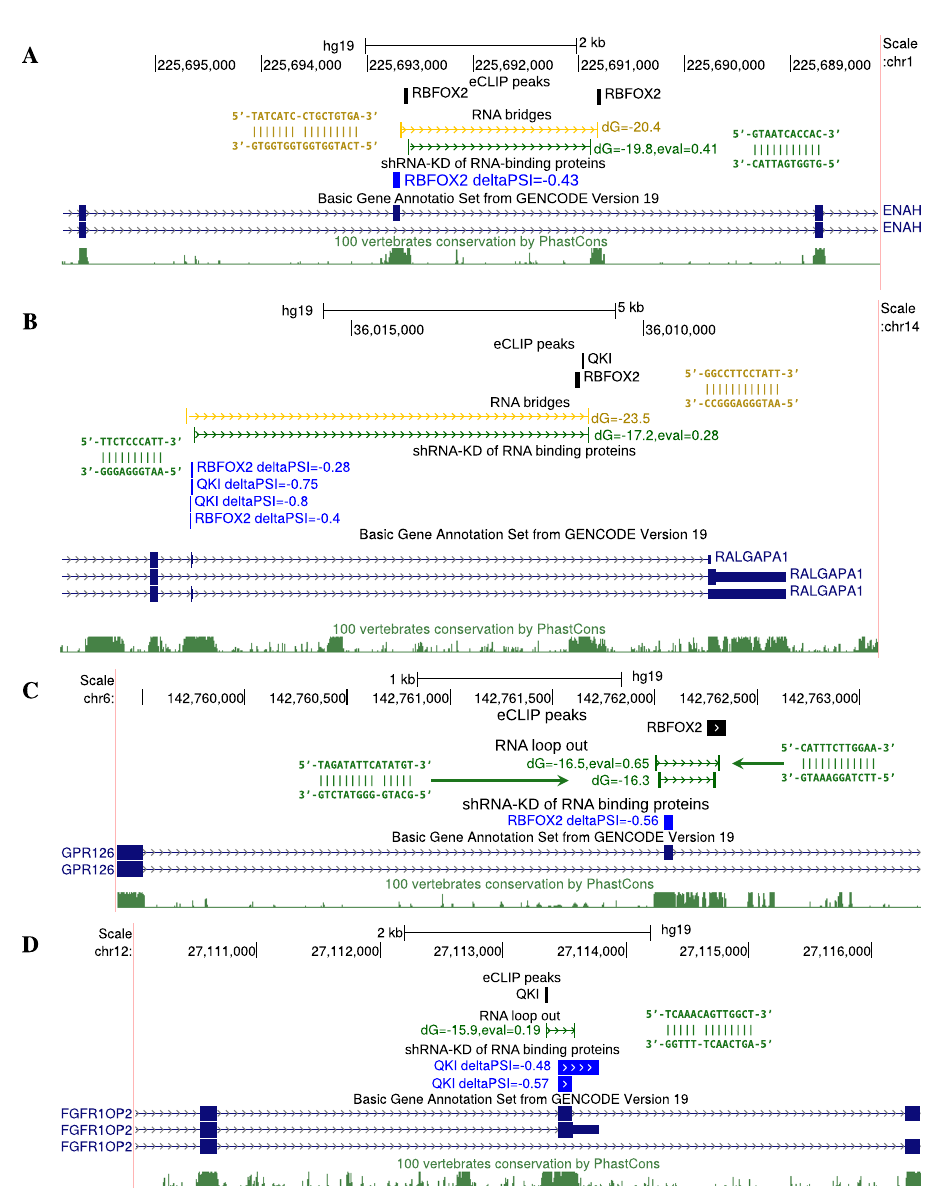
inclusion rate substantially decreases under RBFOX2 depletion ( ΔΨ = − 0.43). B The predicted RNA bridge in RALGAPA1 brings distant binding sites of